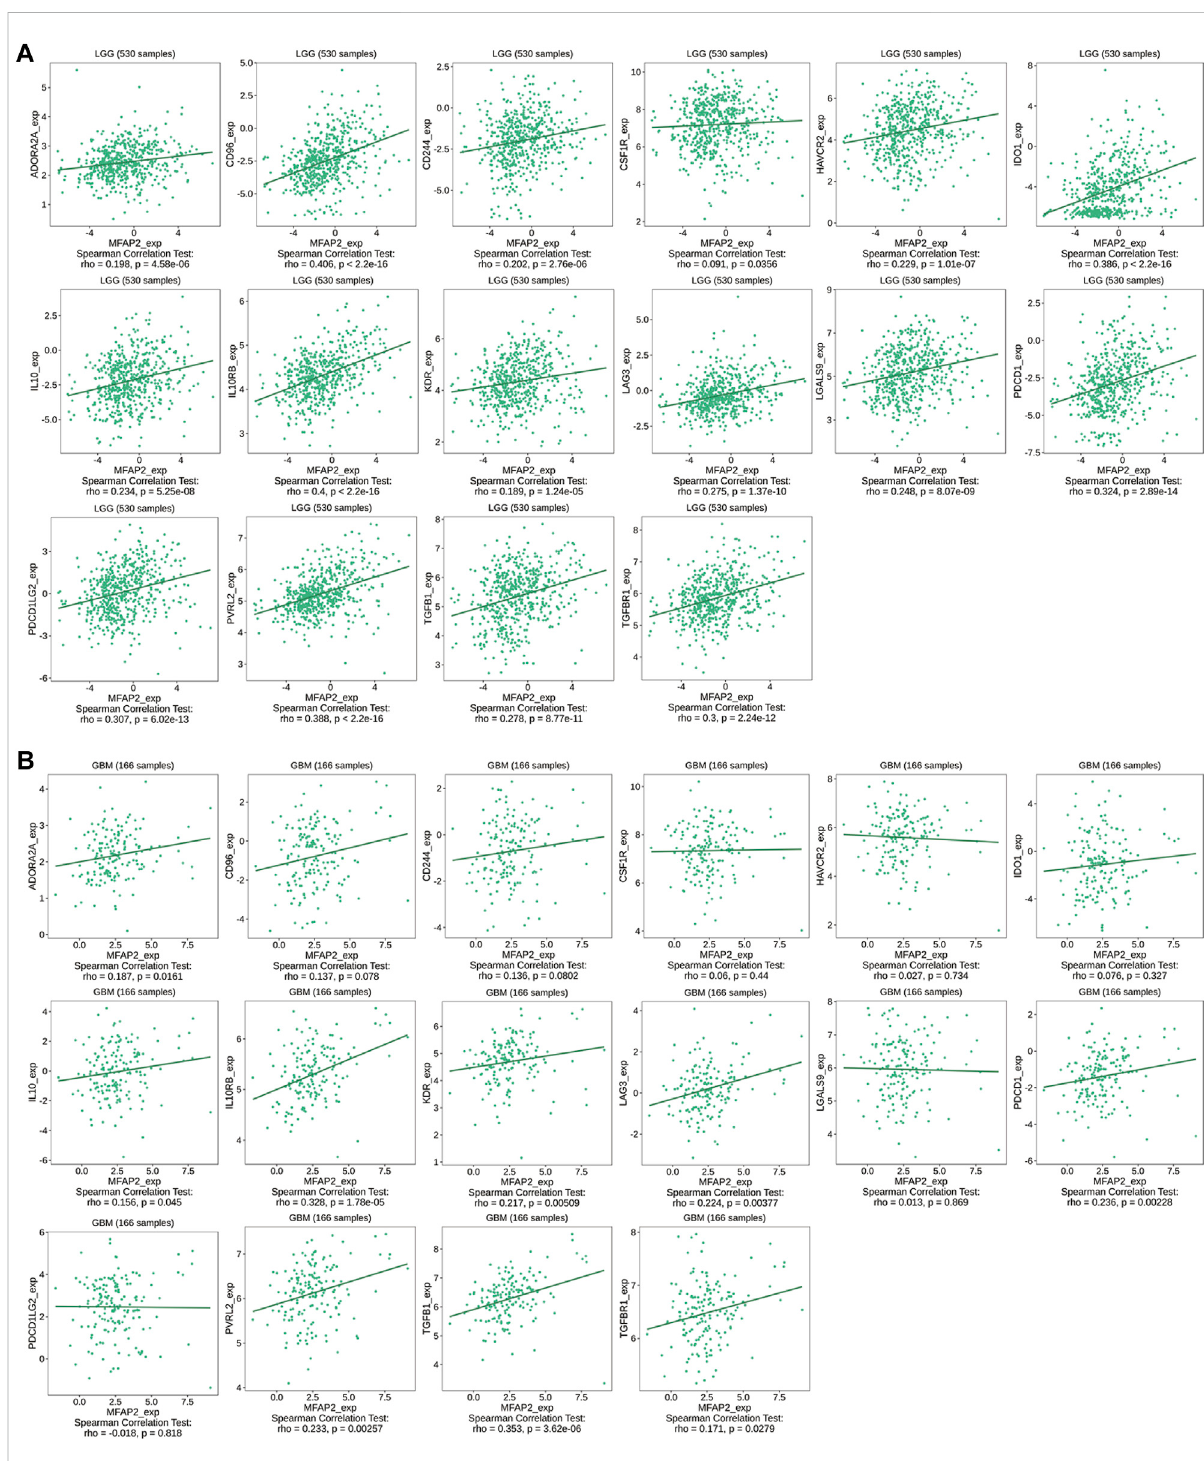
FIGURE 6 Relevance between MFAP2 expression and immunoinhibitors in glioma in the TISIDB database. Correlation between MFAP2 expression and immunoinhibitors (ADORA2A, CD96, CD244, CSF1R, HAVCR2, IDO1, IL10, IL10RB, KDR, LAG3, LGALS9, PDCD1, PDCD1LG2, PVRL2, TGFB1, and TGFBR1) in LGG (A) and in GBM (B) . Color images are available